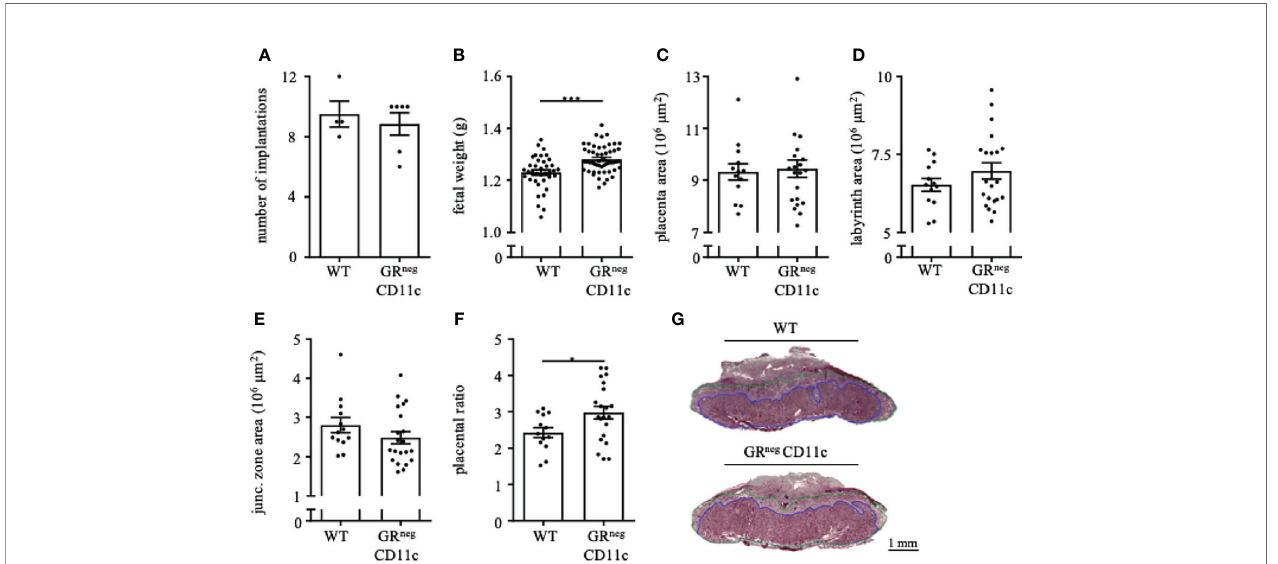
FIGURE 5 | Improved fetal and placental outcome due to an impaired glucocorticoid-responsiveness of CD11c + dendritic remains till the end of pregnancy. WT and GRnegCD11c female mice were allogenically mated to Balb/c males and pregnancy outcome was assessed on gestational day (gd) 18.5: number implantation (A) , fetal weight (B) and overall placental area (C) . Area of the labyrinth (D) and the junctional zone (E) have been assessed and the placental ratio (F) was calculated. (G) Representative photomicrographs illustrating mid-sagittal sections of gd 18.5 placental tissue from WT (top) and GRnegCD11c (bottom) mothers, black line in the picture denotes 1mm, blue lines encircle the labyrinth, green lines surround the junctional zone. Scatter-bar-plots represent mean ± SEM, Student ’ s t test, *p ≤ 0.05, ***p ≤ 0.001. Each dot in the scatter plot represents a single animal (A, B) or a single placenta (C – F) ,